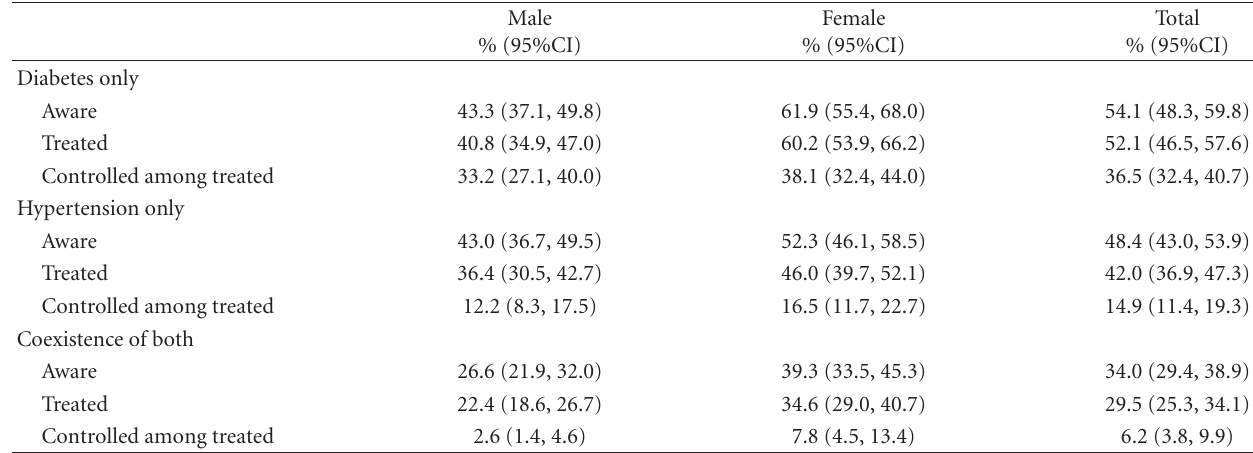
Table 3: Proportion of awareness, treated, and controlled of those having diabetes, hypertension, and coexistence of both conditions in Thai population aged ≥ 15